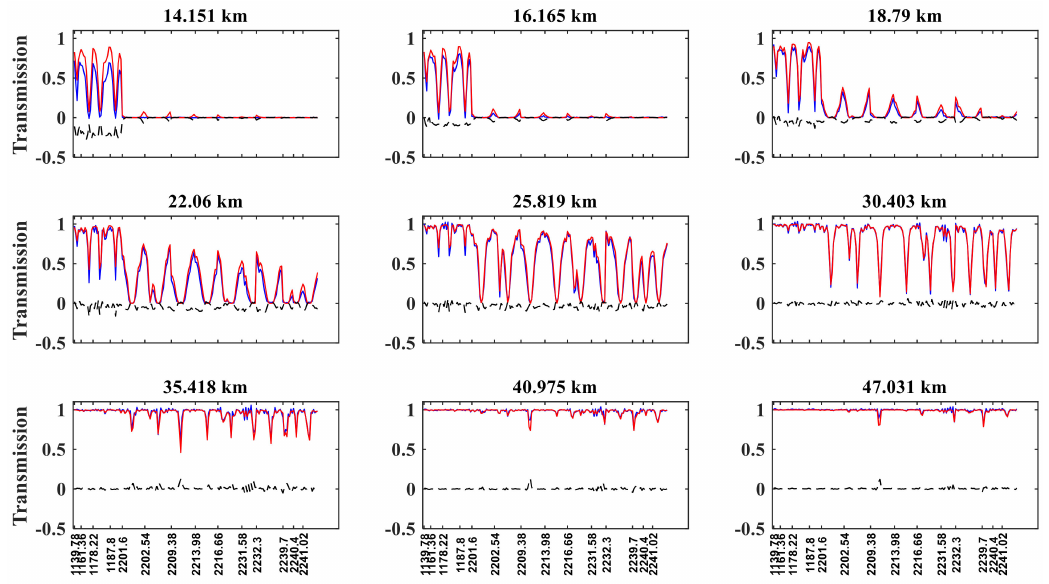
Figure 3. Reference transmission (blue curve), simulated transmission (red curve), and the difference between the real and simulated transmissions (black curve) for different tangent heights in N 2 O retrieving channels, by reference to sunrise orbit 40993 of ACE-FTS. The x -axis represents the wavenumber; the y -axis represents